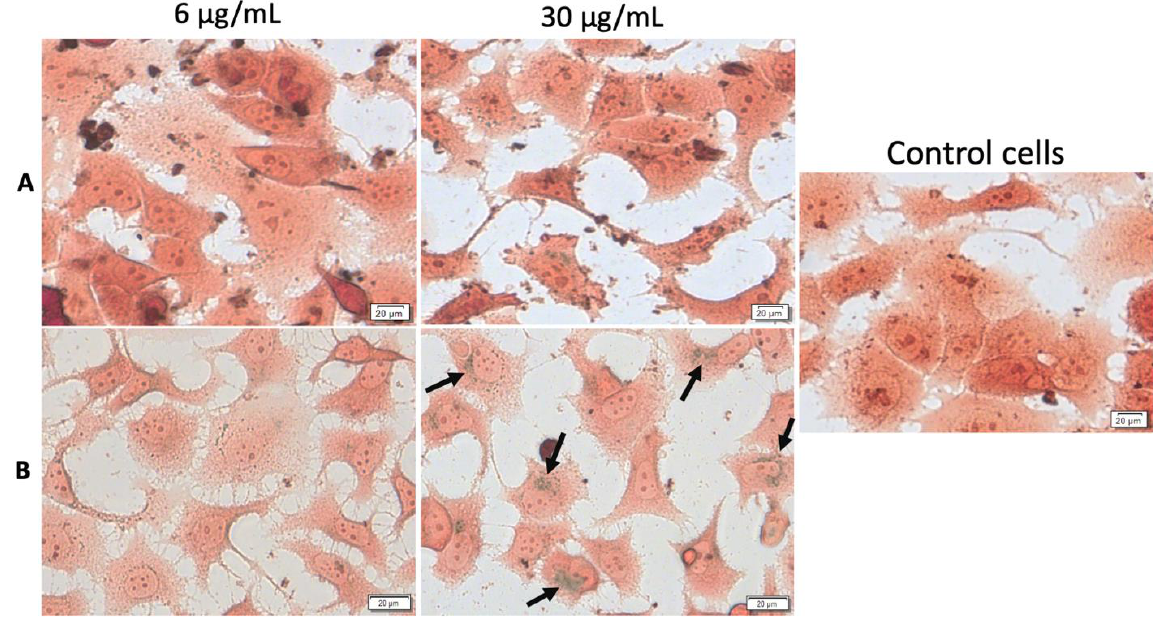
Figure 15. Cellular internalization of MCS within MCF-7 cells under standard ( A ) and hyperthermic conditions ( B ). The cells were visualized under bright field microscopy at a magnification of 40×. Scale bars represent 20 µm.